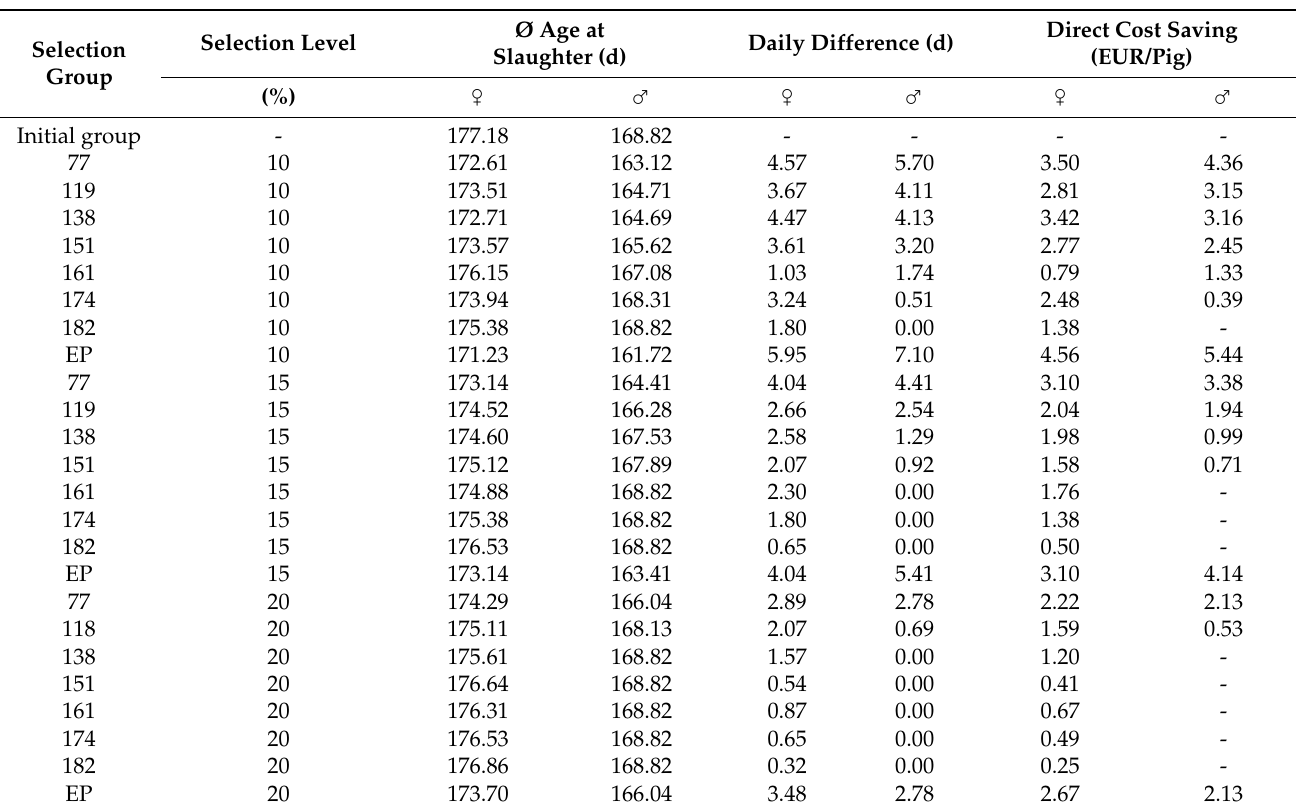
Table 8. Calculation of direct cost savings depending on the selection